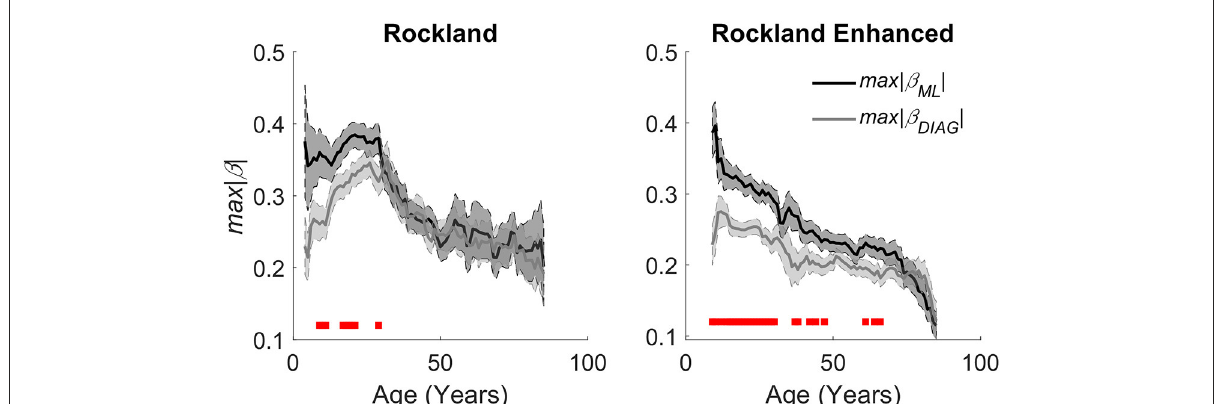
FIGURE5 Aging effects on quantitative estimation of the integrity of caudate gradients. (Left) Caudate spatial integrity estimates across age groups using a sliding window mean of 14 years of the Rockland data sample. (Right) Replication of aging effects in the Rockland Enhanced data sample. Red bars at the bottom represent a significant difference between the two gradients with an alpha of .05, demonstrating that there is a bias in organization across M-L early in age that evens out as the organization degrades with age.